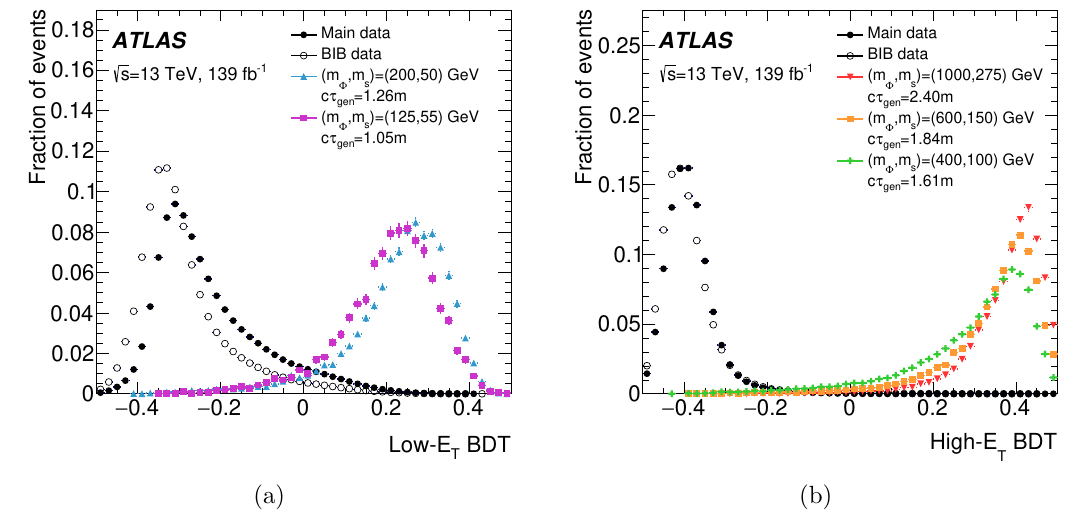
Figure 7. Distribution of the (a) low- E T per-event BDT and (b) high- E T per-event BDT outputs in main data, BIB data and some of the benchmark signal samples after preselection. Only statistical uncertainties are